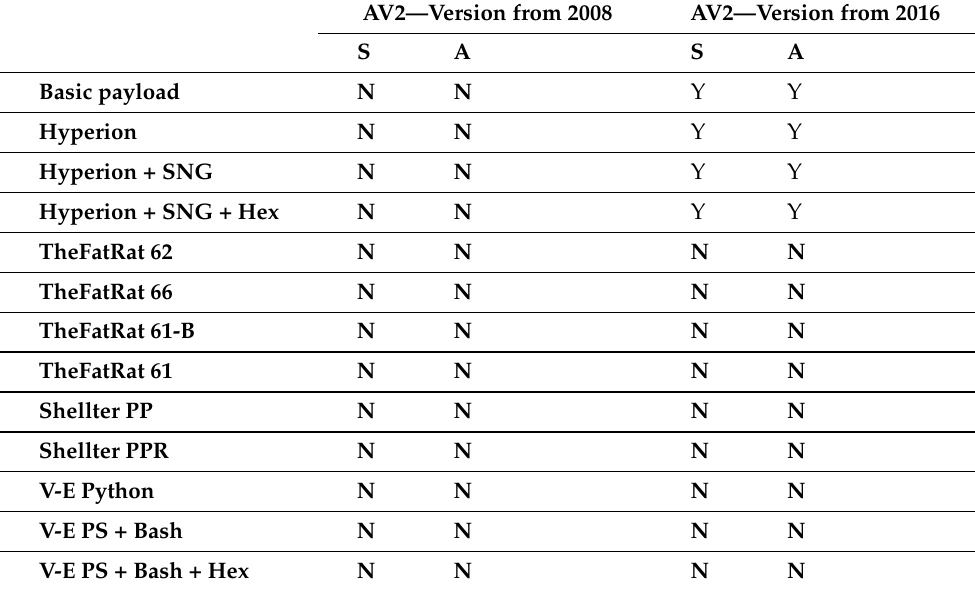
Table 6. Old versions of AV2